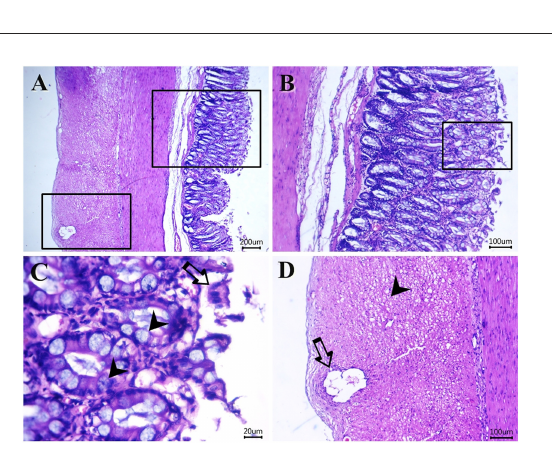
FIGURE5 Photomicrograph of H&E colon sections from healthy cat colon showing: (A) normal histology of mucosa (M), submucosa (SM), inner circular (IC), and outer longitudinal (OL) smooth muscles. Scale bar 200 µ m. (B) Numerous goblet cells within the lamina epithelialis (curved arrow), and no morphological changes in the submucosal layer (star label). Scale bar 100 µ m. (C) Normal myenteric plexus (arrow) between the inner and outer muscular layers. Scale bar 100 µ m.